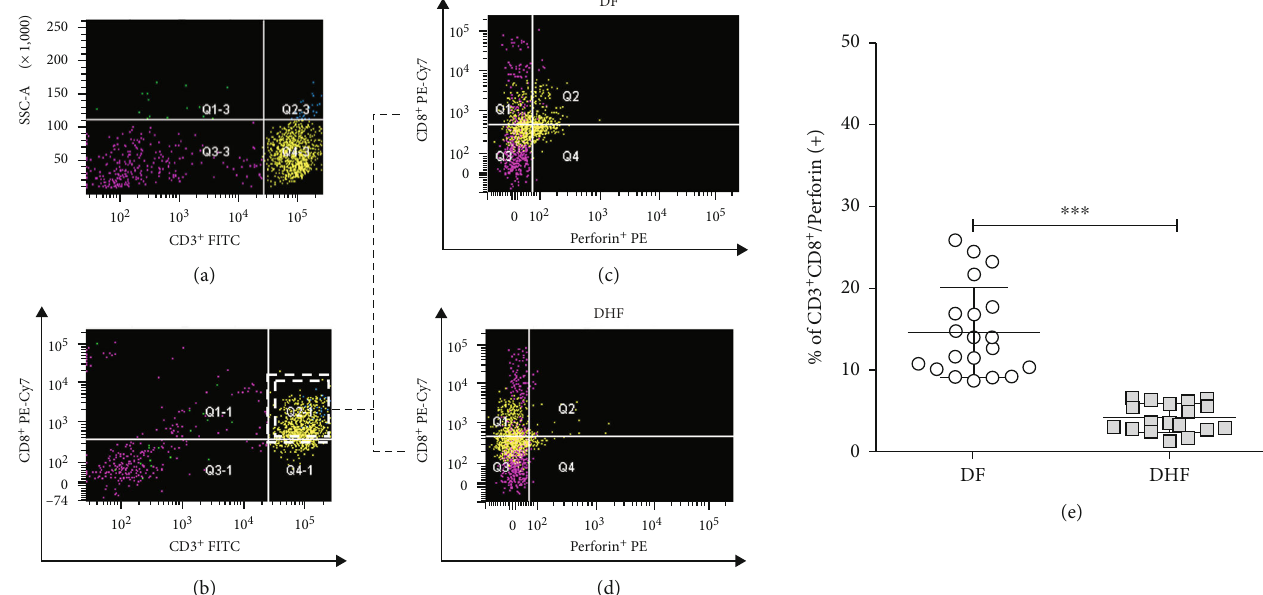
Figure 2: Analysis of functional cytotoxic T lymphocytes in ex vivo PBMC of patients with dengue fever (DF) and dengue hemorrhagic fever (DHF) by fl ow cytometry. Representative plots of the gating strategy for the analysis of CD3 + /CD8 + /perforin + T cells (a – d). First, singlets and live cells were selected. (a) CD3 + and (b) CD3 + /CD8 + double positive cells were gated and used to determine perforin expression in (c) DF and (d) DHF patients. (e) Percentages of activated CD3 + CD8 + perforin + cells in patients with DF ( n = 23 ) and DHF patients ( n = 20 ). The error bars represent mean ± SD . ∗∗∗ p < 0 : 001 determined by the Mann – Whitney U cytometry using CFSE to label T cells. The strategy to ana- lyze CD4 and CD8 proliferating T cells is shown in Figure 5; the objective was to evaluate the relative frequency of proliferating (CFSE low) and nonproliferating (CFSE high) in CD4 + and CD8 + cells. The proportion of proliferat- ing CD4 and CD8 cells induced by viral peptides in DF and DHF is shown in Figure 6.